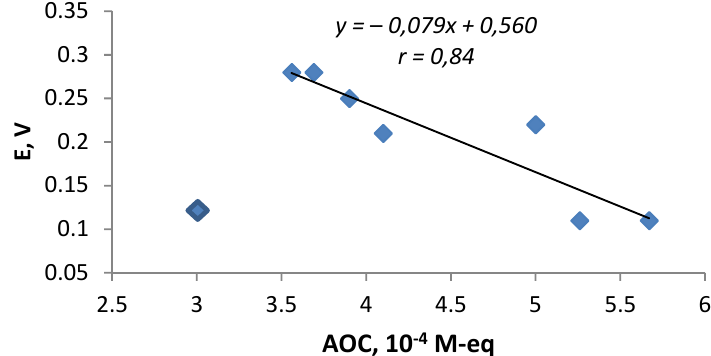
Figure 4. Correlation between the oxidation peak potential and the AOC.